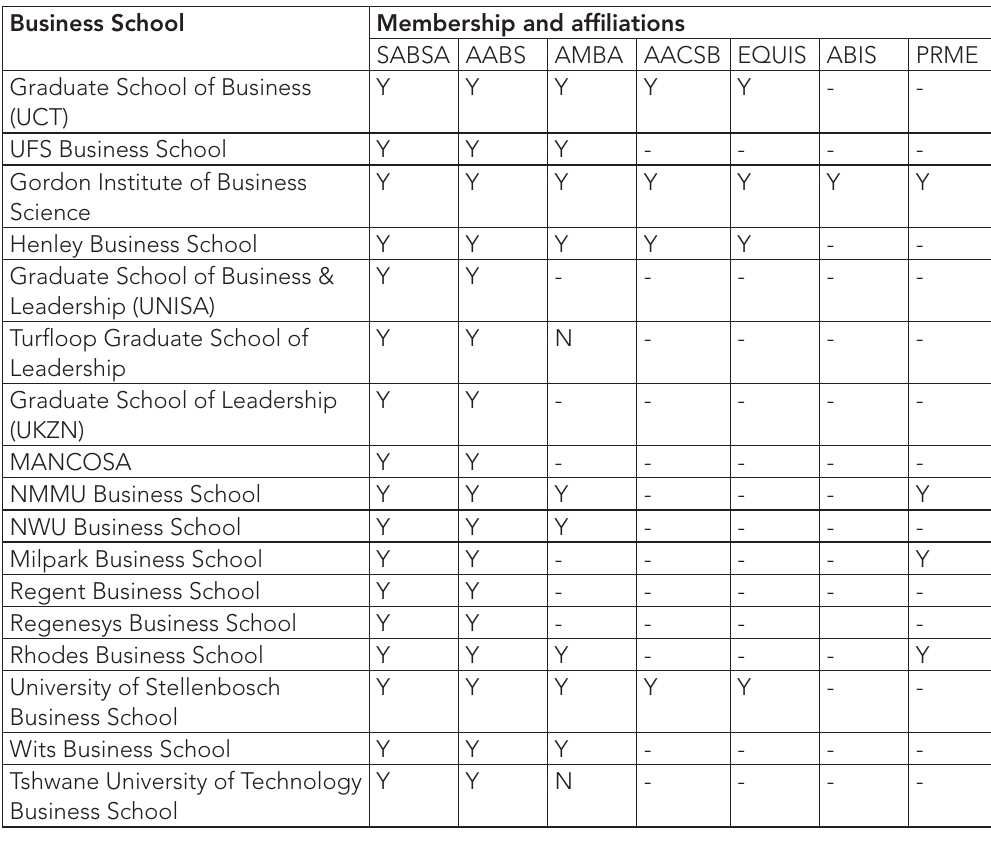
Table 4: Membership, accreditations and